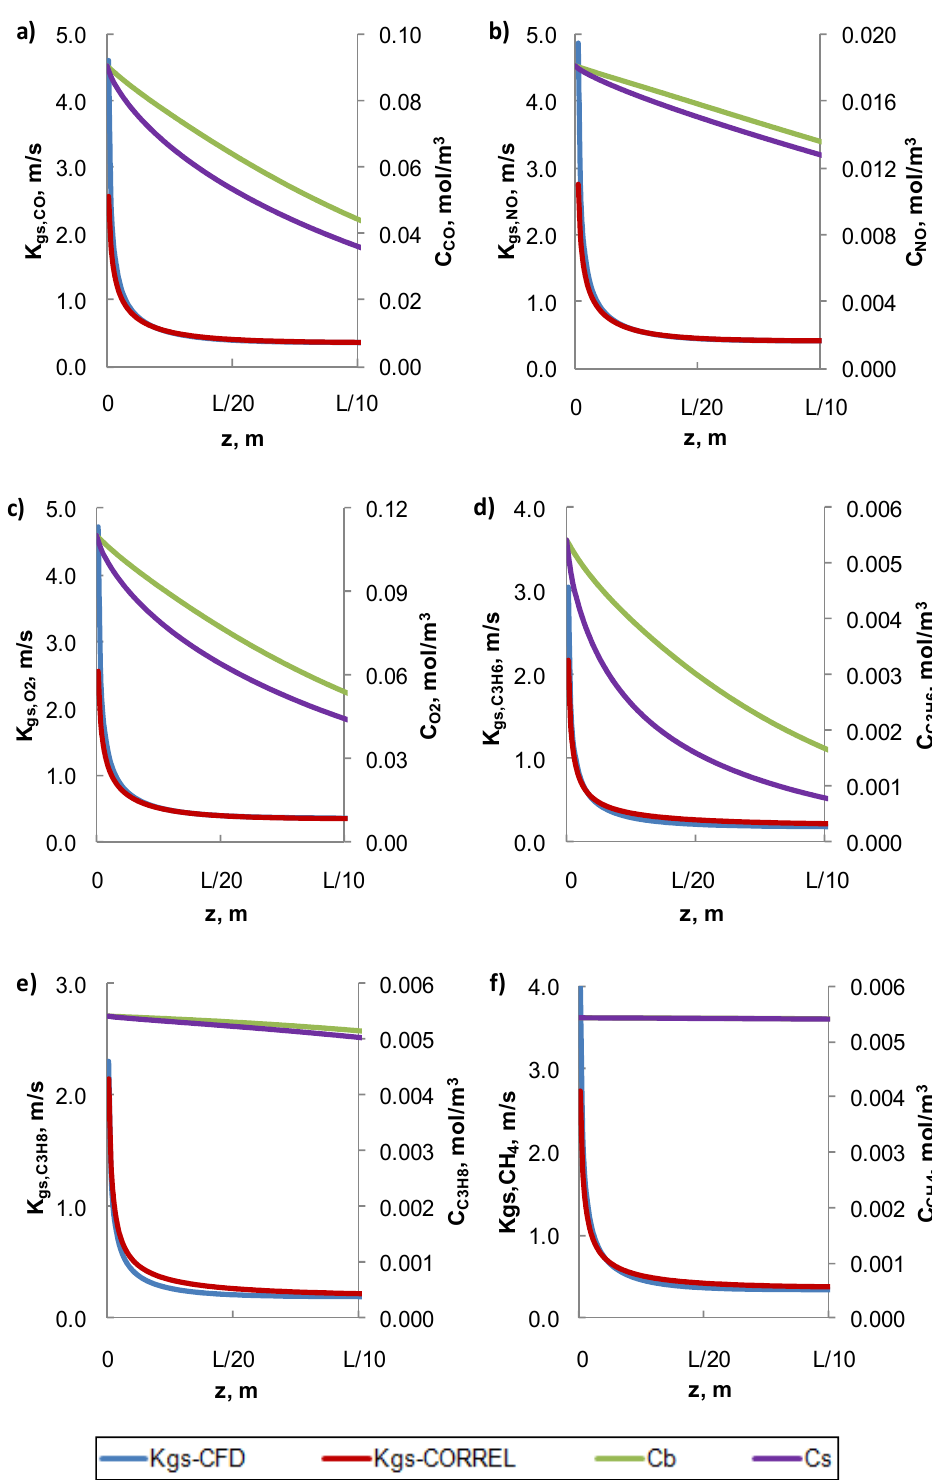
Figure 2. Representative figures for the comparison of K gs profiles along the cell length predicted by the proposed correlation with those derived from CFD calculations as well as a comparison of the concentration profiles in the bulk of the gas phase and over the catalytic surface. Cell diameter d = 1.1 mm. Temperature 400 ◦ C. Velocity 0.261 m / s. Re = 4.6. ( a ) CO at lean gas feed composition, ( b ) NO at rich gas feed composition, ( c ) O 2 at rich gas feed composition, ( d ) C 3 H 6 at lean gas feed composition, ( e ) C 3 H 8 at rich gas feed composition and ( f ) CH 4 at rich gas feed composition. Total length L = 1